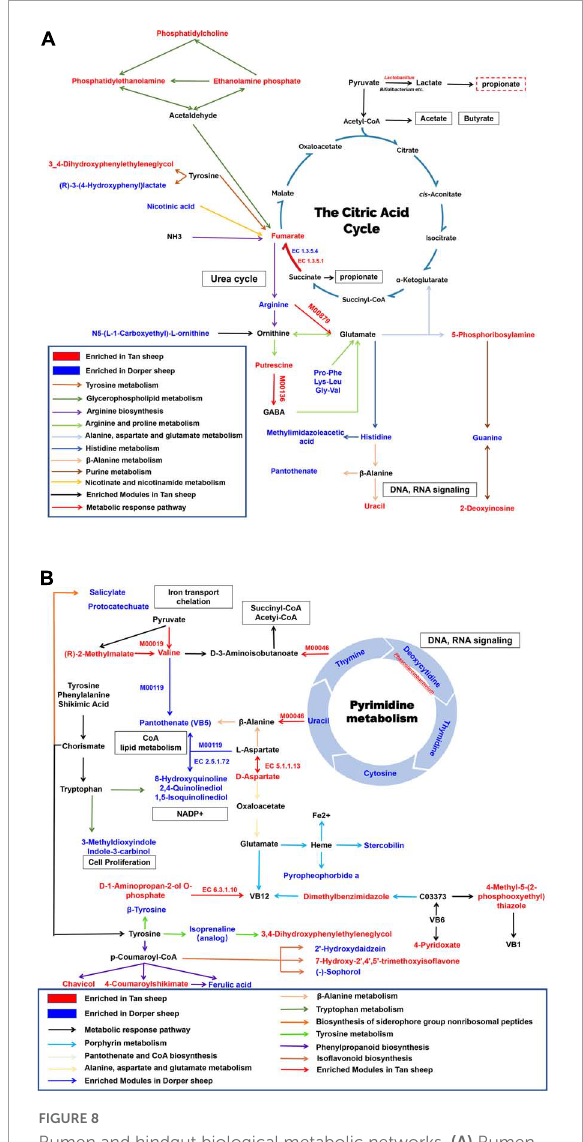
FIGURE8 Rumen and hindgut biological metabolic networks. (A) Rumen metabolic network. (B) Hindgut metabolic network. EC denotes enzymes for KEGG enrichment analysis. M represents a module in a metabolic pathway. Red represents metabolites abundant in Tan sheep, blue represents metabolites abundant in Dorper sheep, and black represents metabolites with no significant difference. Squares indicate involved biological processes. The enriched metabolites were P- value < 0.05, VIP >